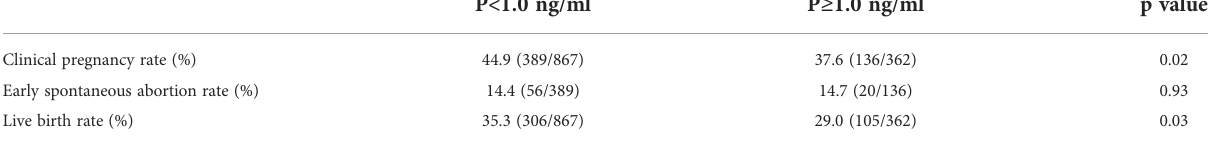
Data are presented as % (n/N) for categorical